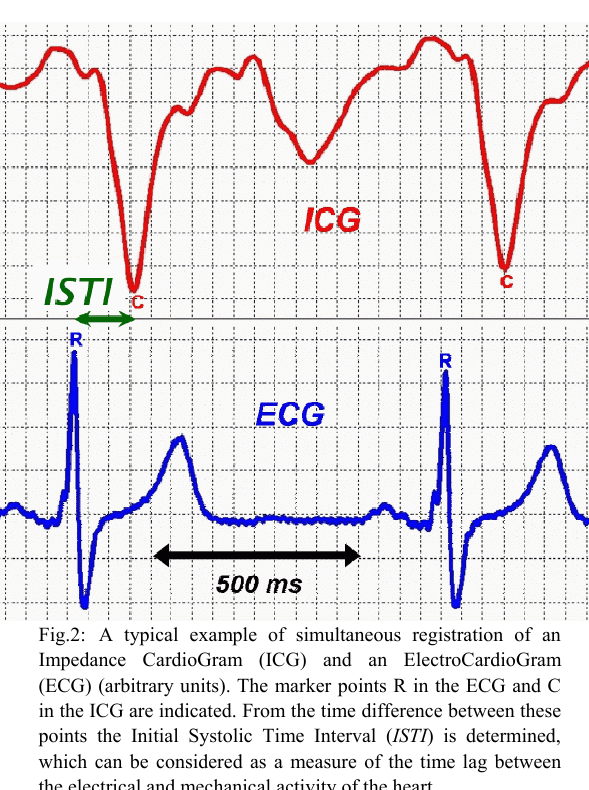
Fig.2: A typical example of simultaneous registration of an Impedance CardioGram (ICG) and an ElectroCardioGram (ECG) (arbitrary units). The marker points R in the ECG and C in the ICG are indicated. From the time difference between these points the Initial Systolic Time Interval ( ISTI ) is determined, which can be considered as a measure of the time lag between the electrical and mechanical activity of the heart.